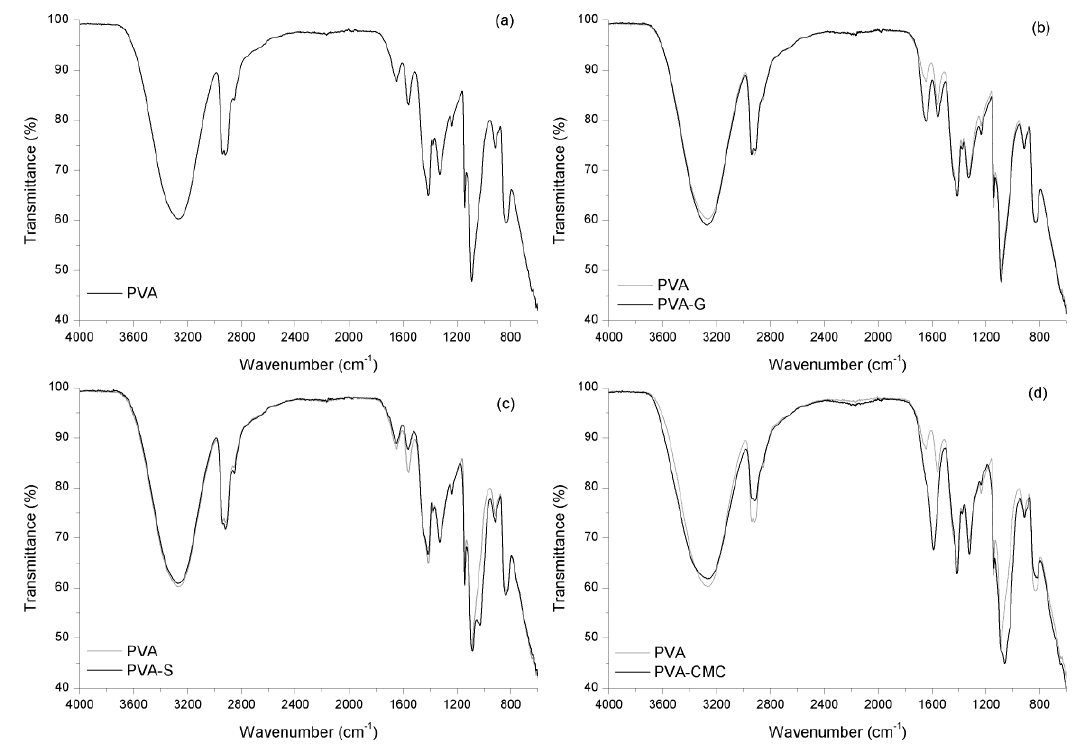
Figure 1. Spectra of PVA (polyvinyl alcohol) blends: ( a ) PVA, ( b ) PVA-G (poly vinyl alcohol – gelatin), ( c ) PVA-S (poly vinyl alcohol –starch) and ( d ) PVA-CMC (polyvinyl alcohol – sodium carboxymethyl